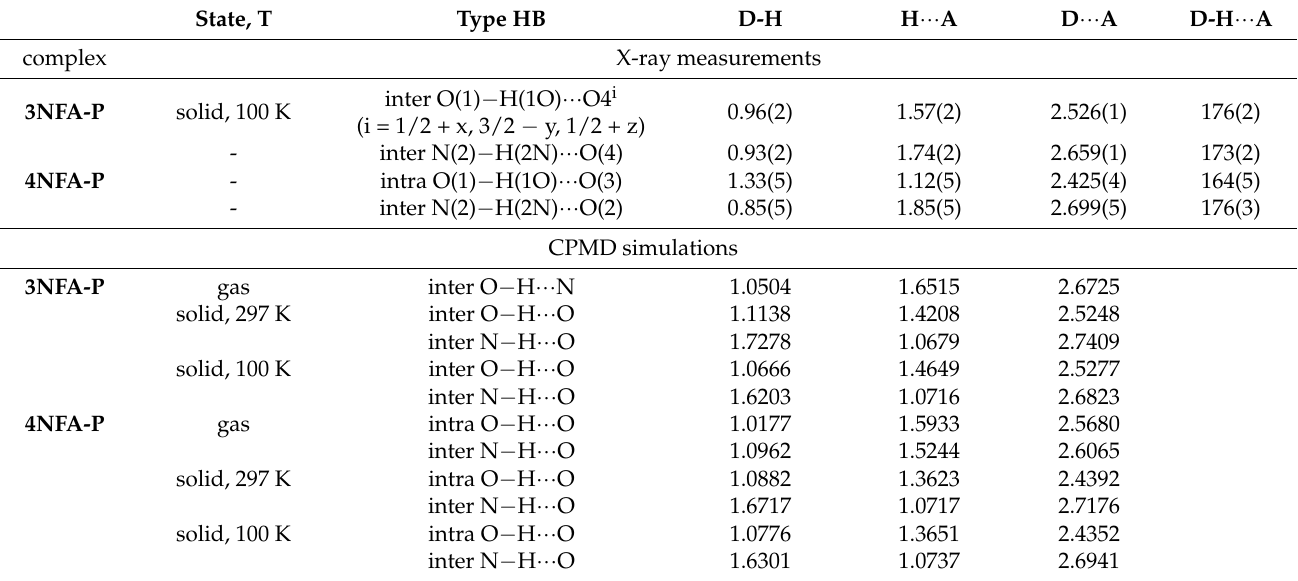
Table 1. Structural parameters (in Å) for the donor-acceptor (O ... O) and donor-proton (OH) dis- tances in complexes 3NFA-P and 4NFA-P obtained by X-ray measurements and CPMD